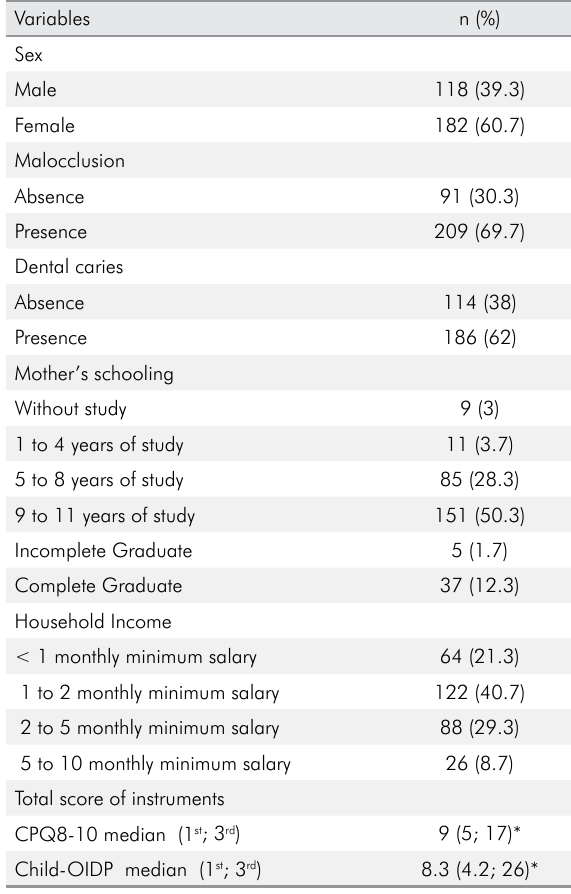
Table 1. Descriptive statistics of the participating children (n =